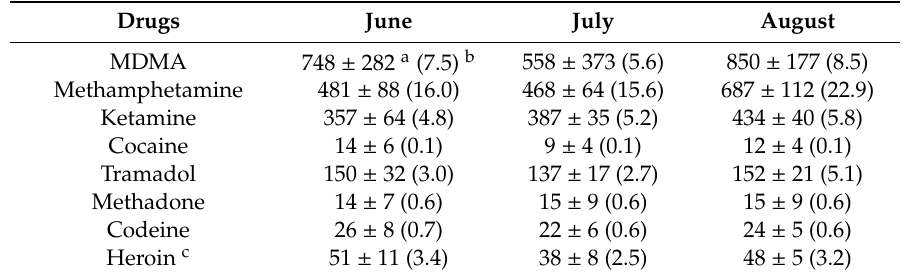
Table 3. Estimated community consumption (mg / 1000 inh / d) and mean dose (dose / 1000 inh / d) of drugs serviced by